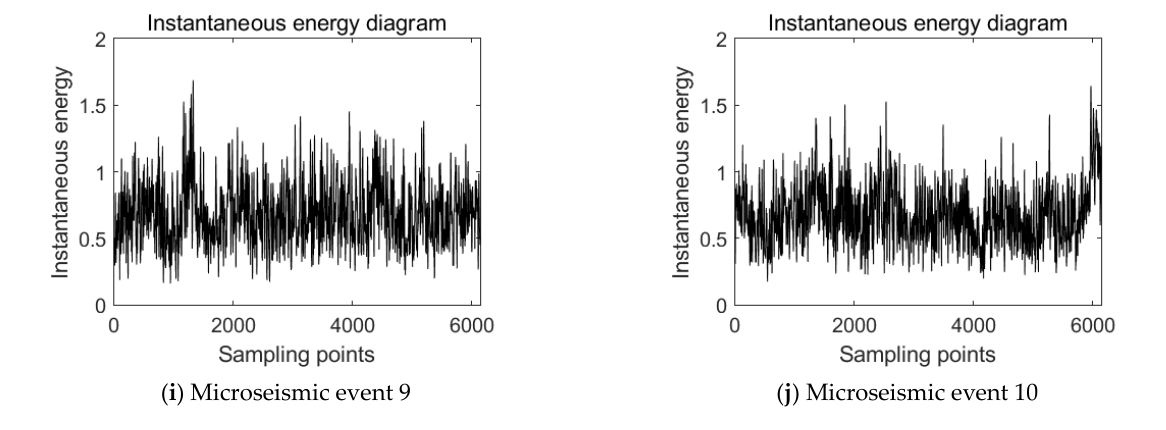
Figure 8. Instantaneous energy of microseismic events.